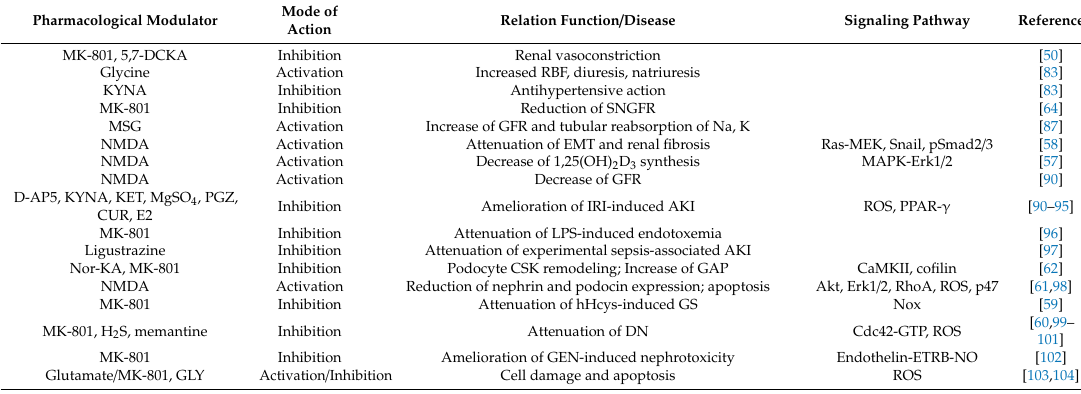
Table 2. Overview of distinctive physiological and pathophysiological functions of renal NMDARs with signaling pathways